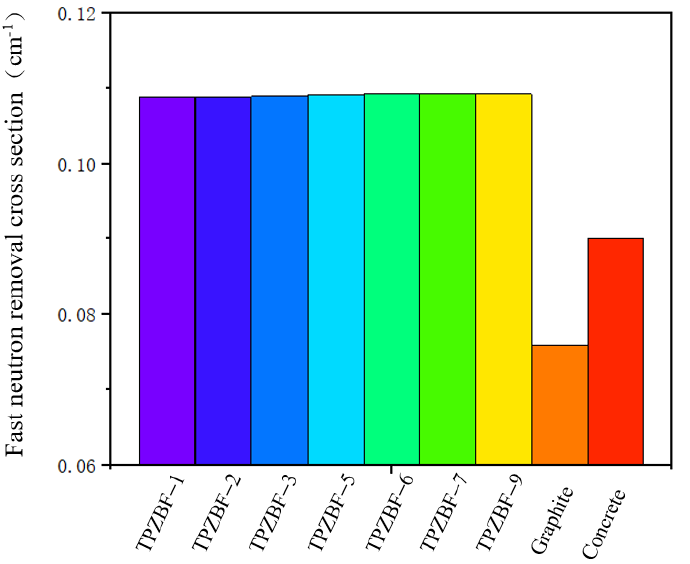
Figure 8. Removal cross section (RCS) of TPZBF series glass, regular concrete, and graphite.